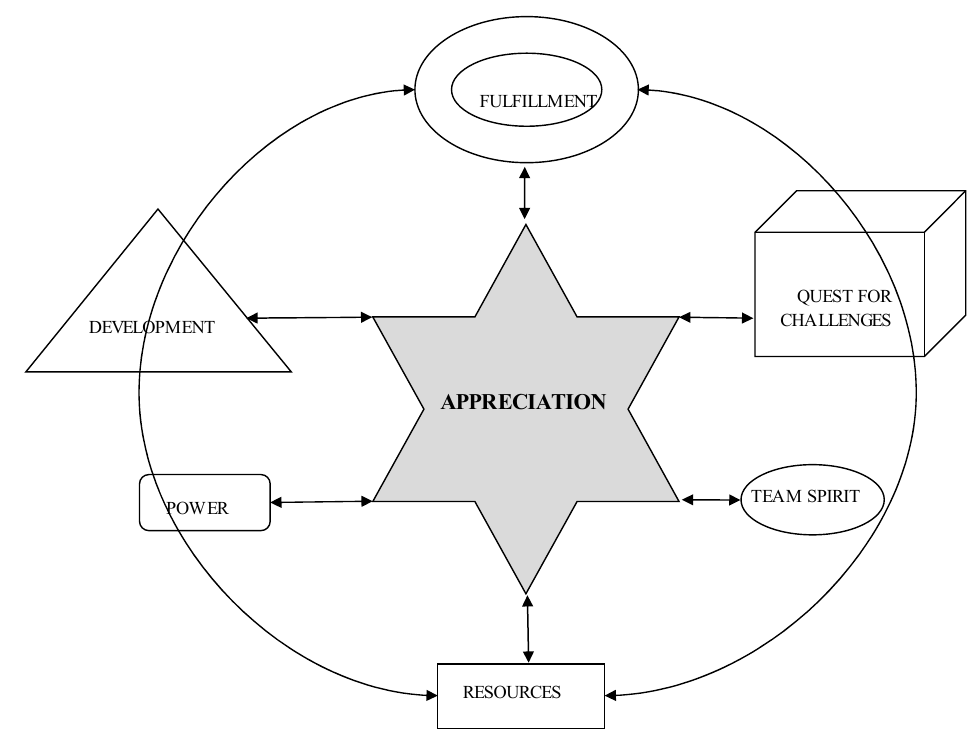
Figure 5. The star-shaped model of the selective codes showing how appreciation is related to all of